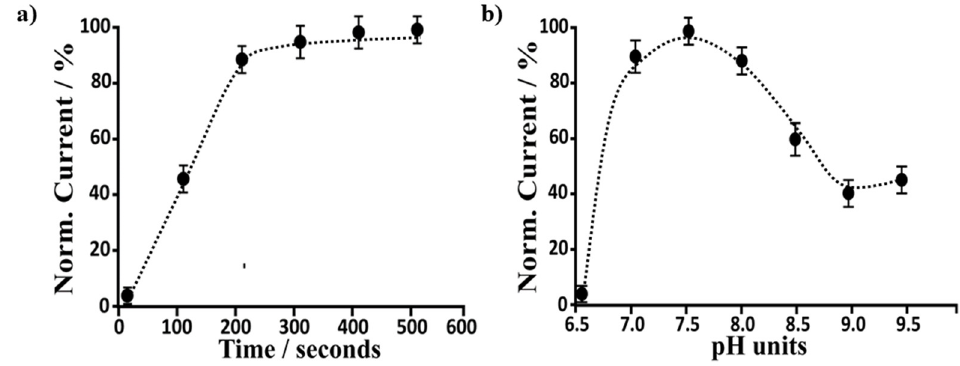
Figure 4. ( a ) Time response and ( b ) working pH values optimization were reported. The results were obtained by analyzing amperometrically bare SPEs in the presence of 1 μ M UA (in a buffer solution, PBS).